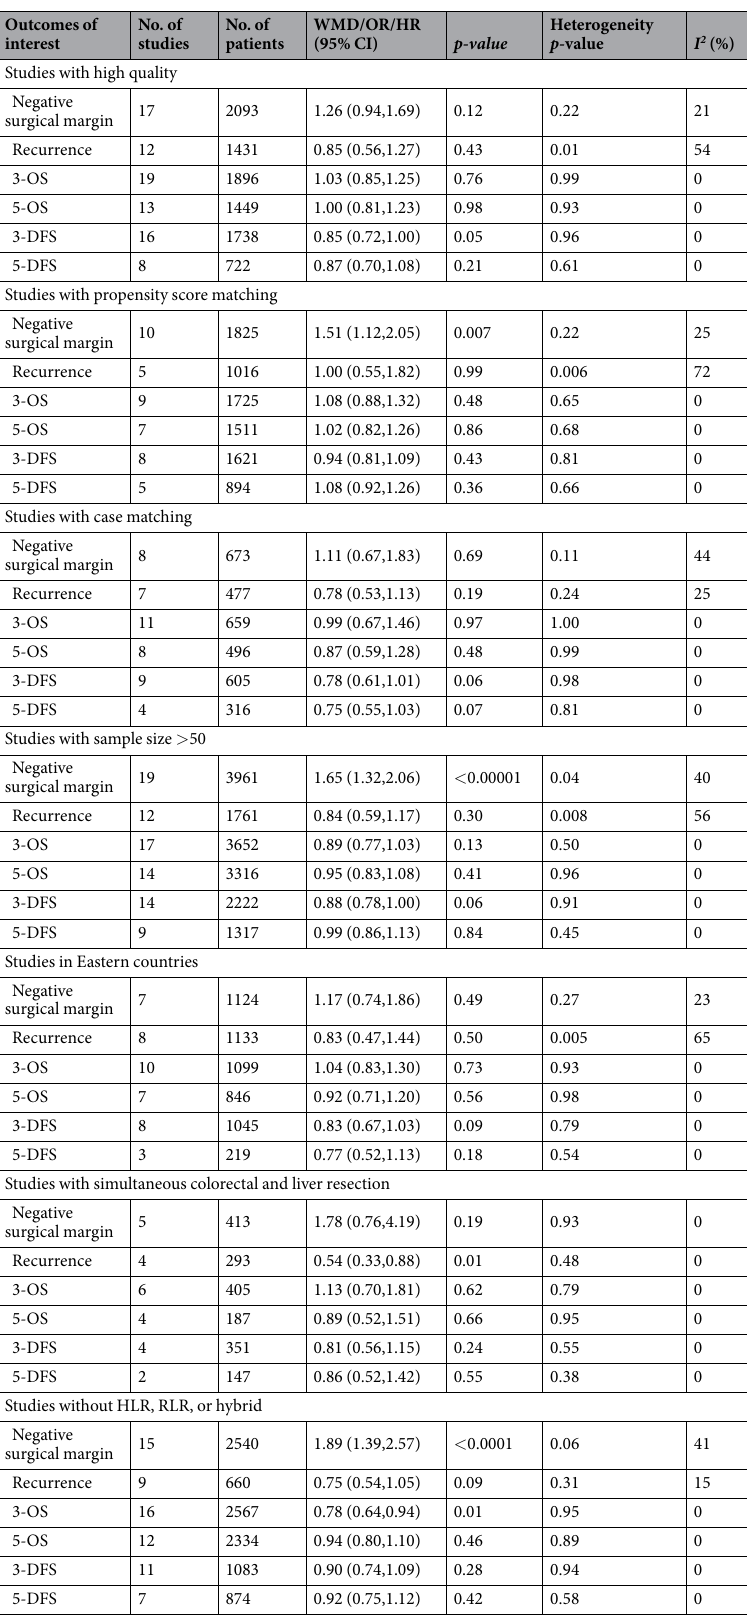
Table 2. The result of subgroup and sensitivity analysis. LLR laparoscopic liver resection, OLR open liver resection, WMD weight mean differences, OR odds ratios; HR hazard ratios; CI confidence intervals, OS overall survival, DFS disease-free survival, HLR hand-assisted liver resection, RLR robotic-assisted liver